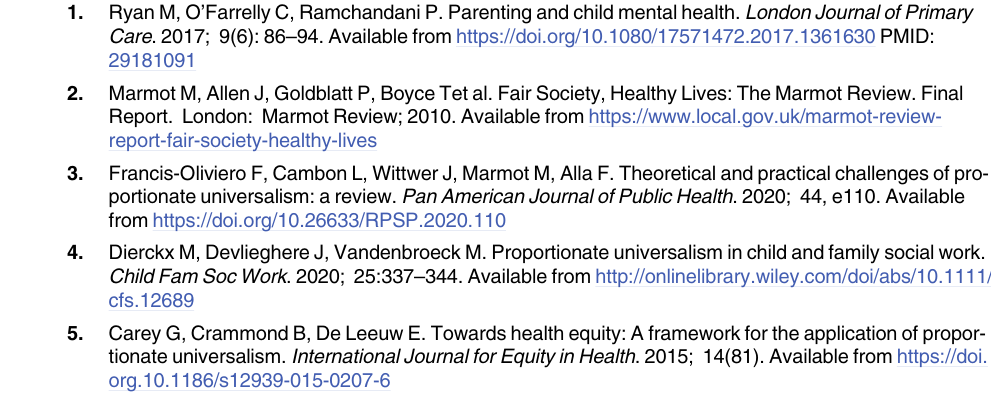
S4 Table. Practitioner characteristics (A) and practitioner confidence in setting up and